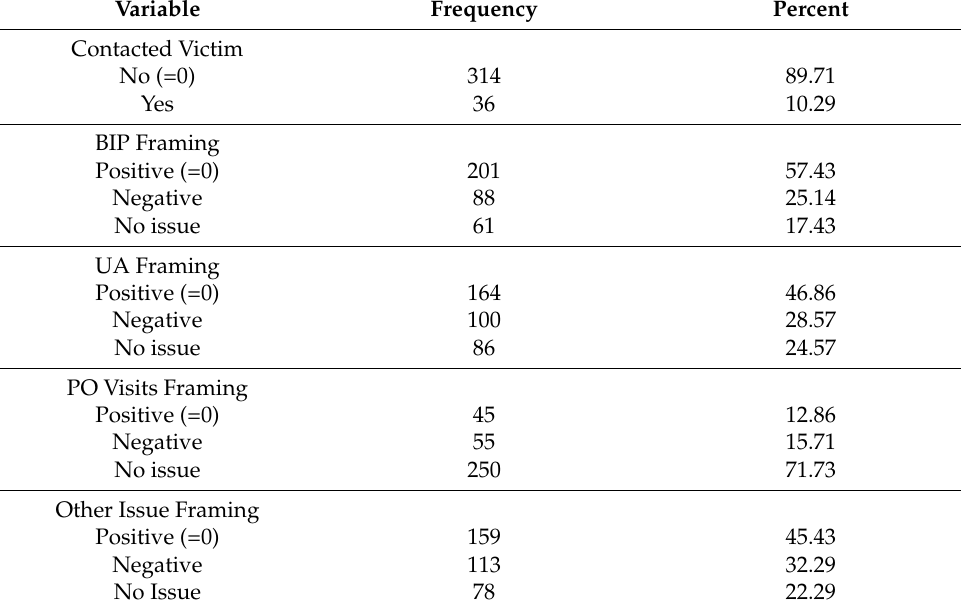
Table 2. Logistic Regression Results Predicting Whether a Probationer was Sanctioned to Jail ( n = 347). Variables